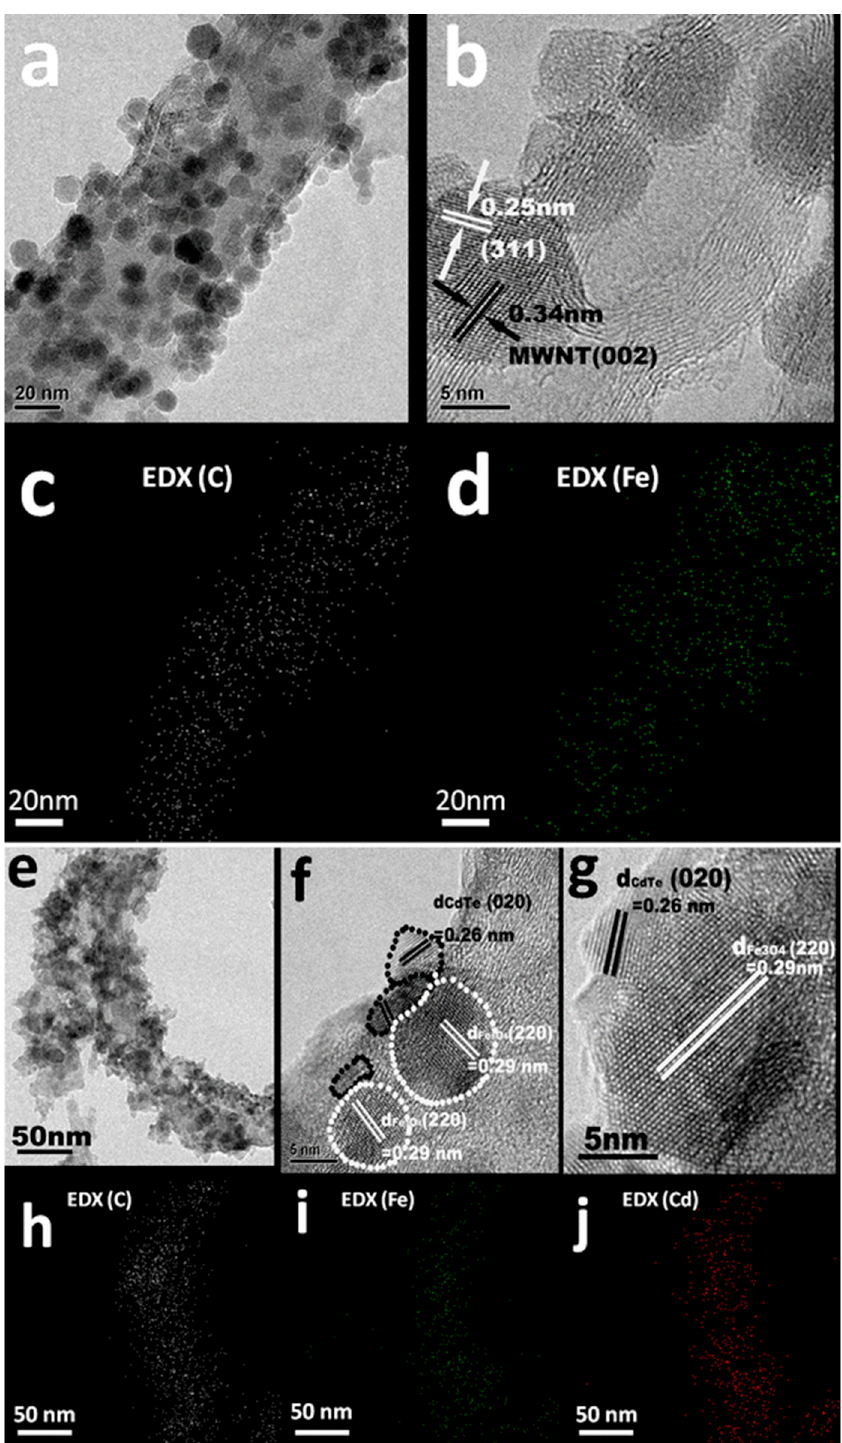
Figure 8. Morphological and structural characterizations of CNT-SPIO ( a – d ) and CNT-SPIO-CdTe nanohybrids ( e – j ) prepared by LBLassembly in combination with covalent connection technique: ( a ) bright field TEM image of CNT-SPIO; ( b ) HRTEMimageof CNT-SPIO; ( c , d ) EDX elemental mapping of C and Fe with a specific CNT-SPIO nanohybrid respectively; ( e ) brightfieldTEMimage of CNT-SPIO-CdTe; ( f , g ) HRTEMimages of CNT-SPIO-CdTe; ( h – j ) EDX elemental mapping of C, Fe and Cd with a specific CNT-SPIO-CdTenanohybrid respectively. Adapted from ref. [63].